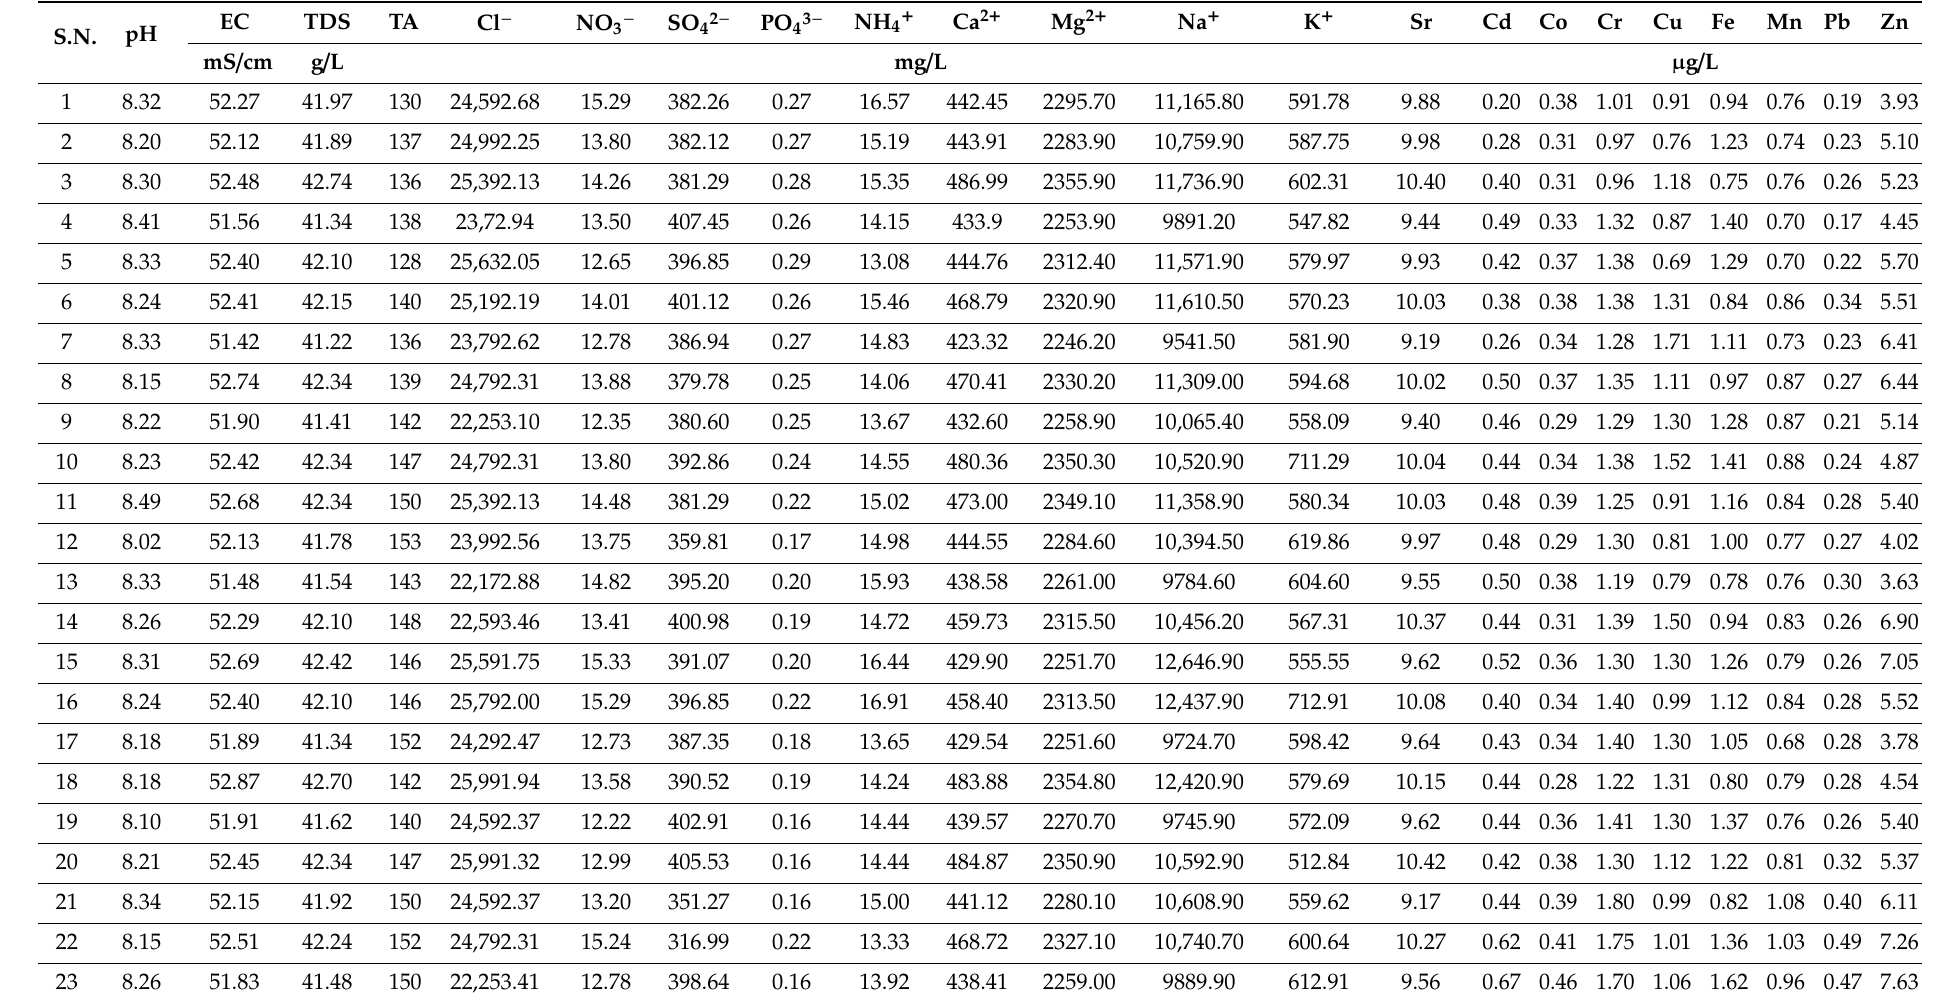
Table 1. Characteristics of surface seawater layer, GoA,